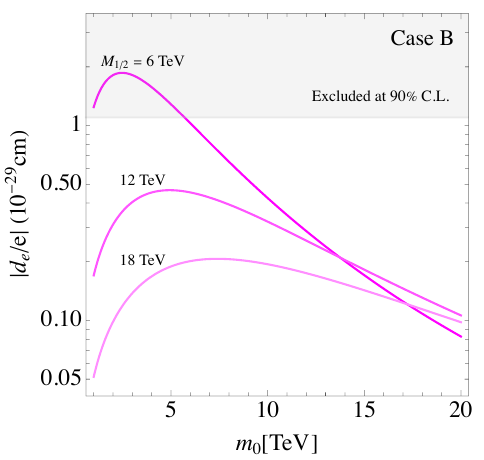
Figure 4 . The predicted BR( µ → eγ ) versus m 0 with putting F τ = m 0 / 2 in case B. The grey region is excluded by the experimental up- per